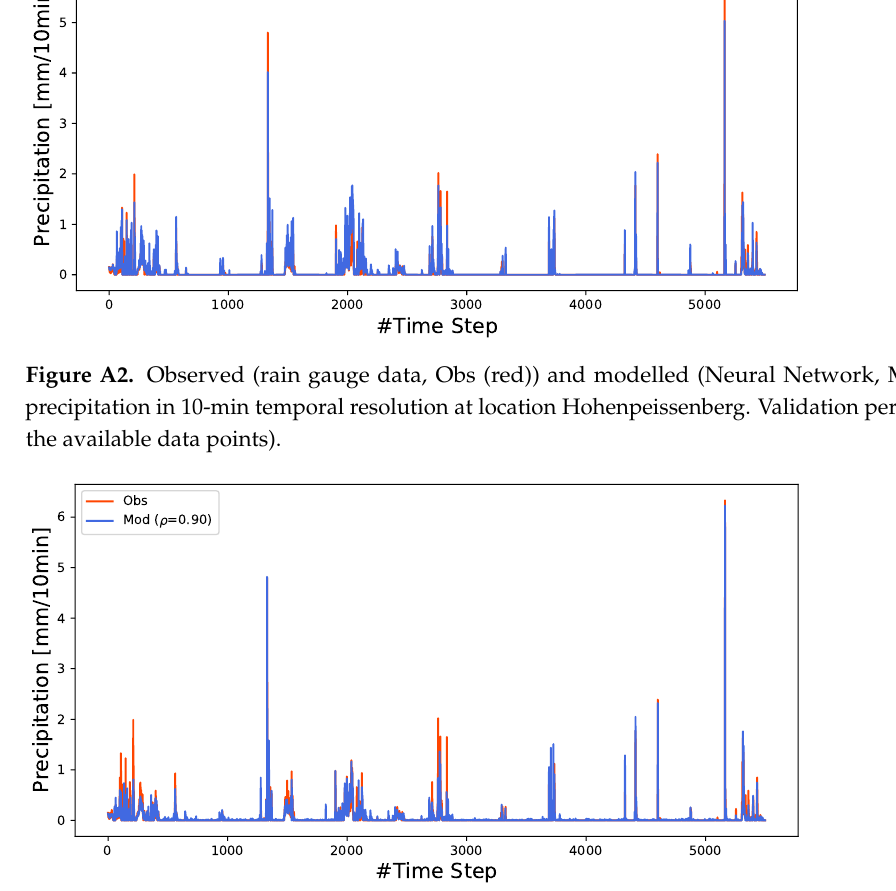
Figure A3. Observed (rain gauge data, Obs (red)) and modelled (Neural Network, Mod (blue)) precipitation at location Hohenpeissenberg in 10-min resolution on the Validation set (20% of the available data points). The model input consists of reflectivities with time lag up to two as well as selected meteorological